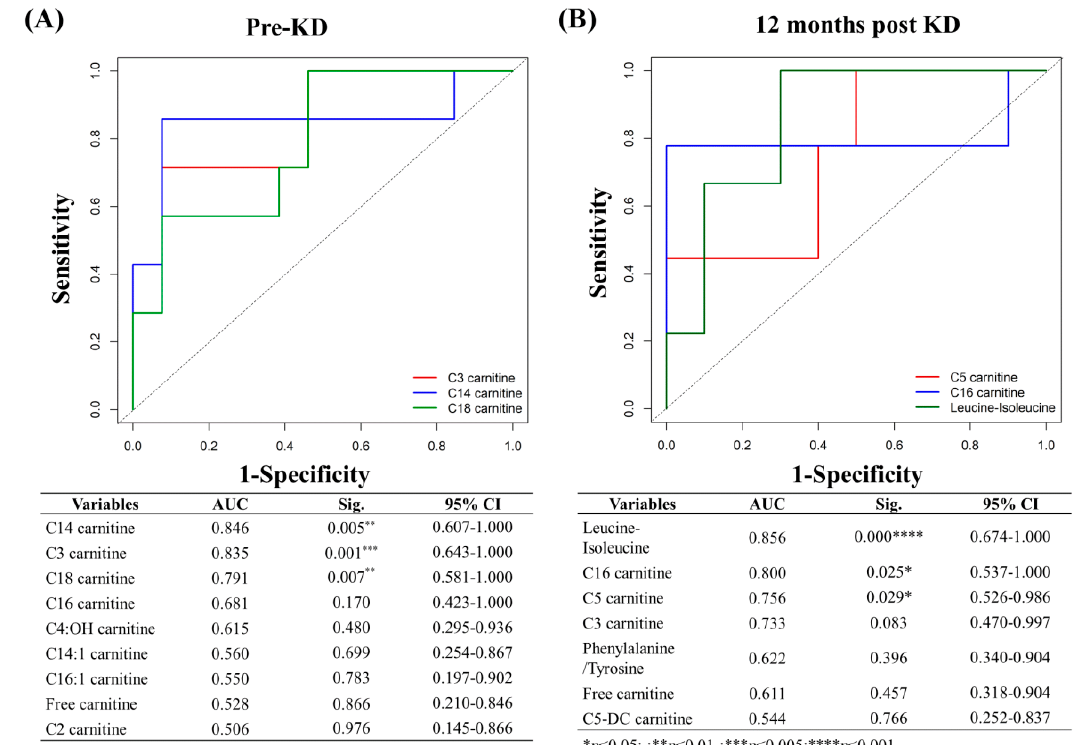
Figure 2. Receiver-operating characteristic (ROC) analysis of the discriminant metabolites between groups. ( A ) Pre-KD; ( B ) 12 months post KD. Individual metabolites of significance (solid lines) are shown along with the reference (dotted line). Area under the curve (AUC) values, significance level, and 95% confidence interval are shown. ( * p < 0.05; ** p < 0.01; *** p < 0.005; **** p < 0.001).